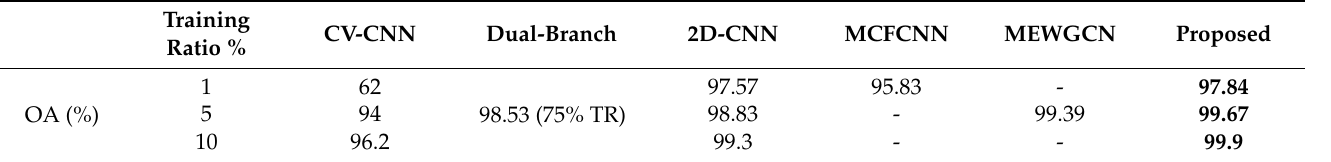
Table 7. Comparison of classification OAs with other studies on AIRSAR Flevoland data. Bold numbers indicate the highest accuracy in each